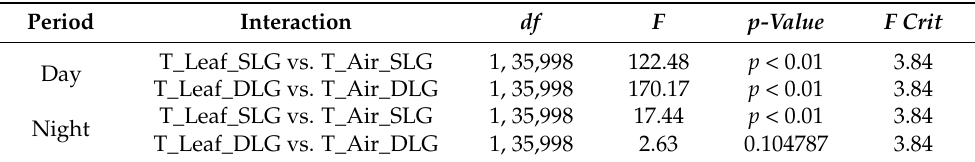
Table 9. ANOVA results of the daytime and nighttime air-leaf temperature interaction in SLG and DLG. SLG: single-layered greenhouse; DLG: double-layered greenhouse.